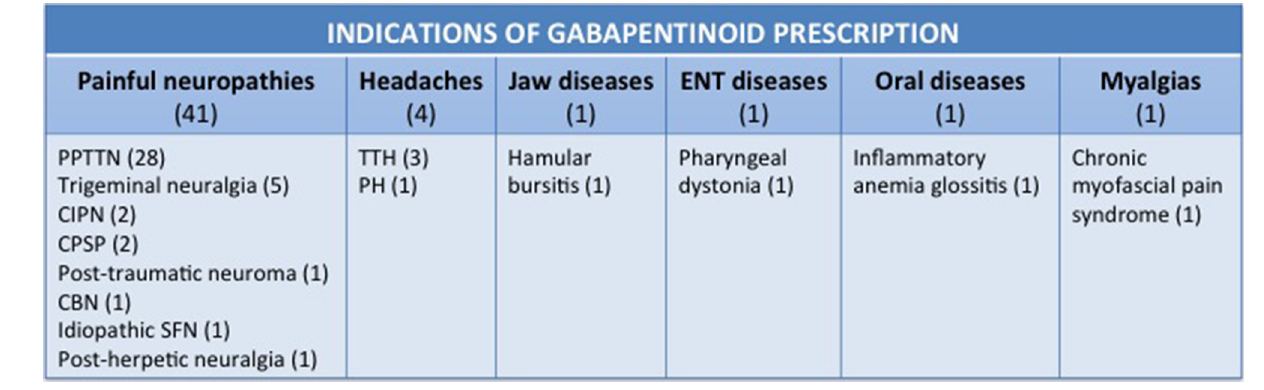
Table I. Indications of gabapentinoid prescription in the tertiary orofacial pain clinic patient cohort (n = 49 patients). PPTTN = Painful Post-Traumatic Trigeminal Neuropathy; CIPN = Chemotherapy-Induced Peripheral Neuropathy; CPSP = Central Post- Hemicrania.